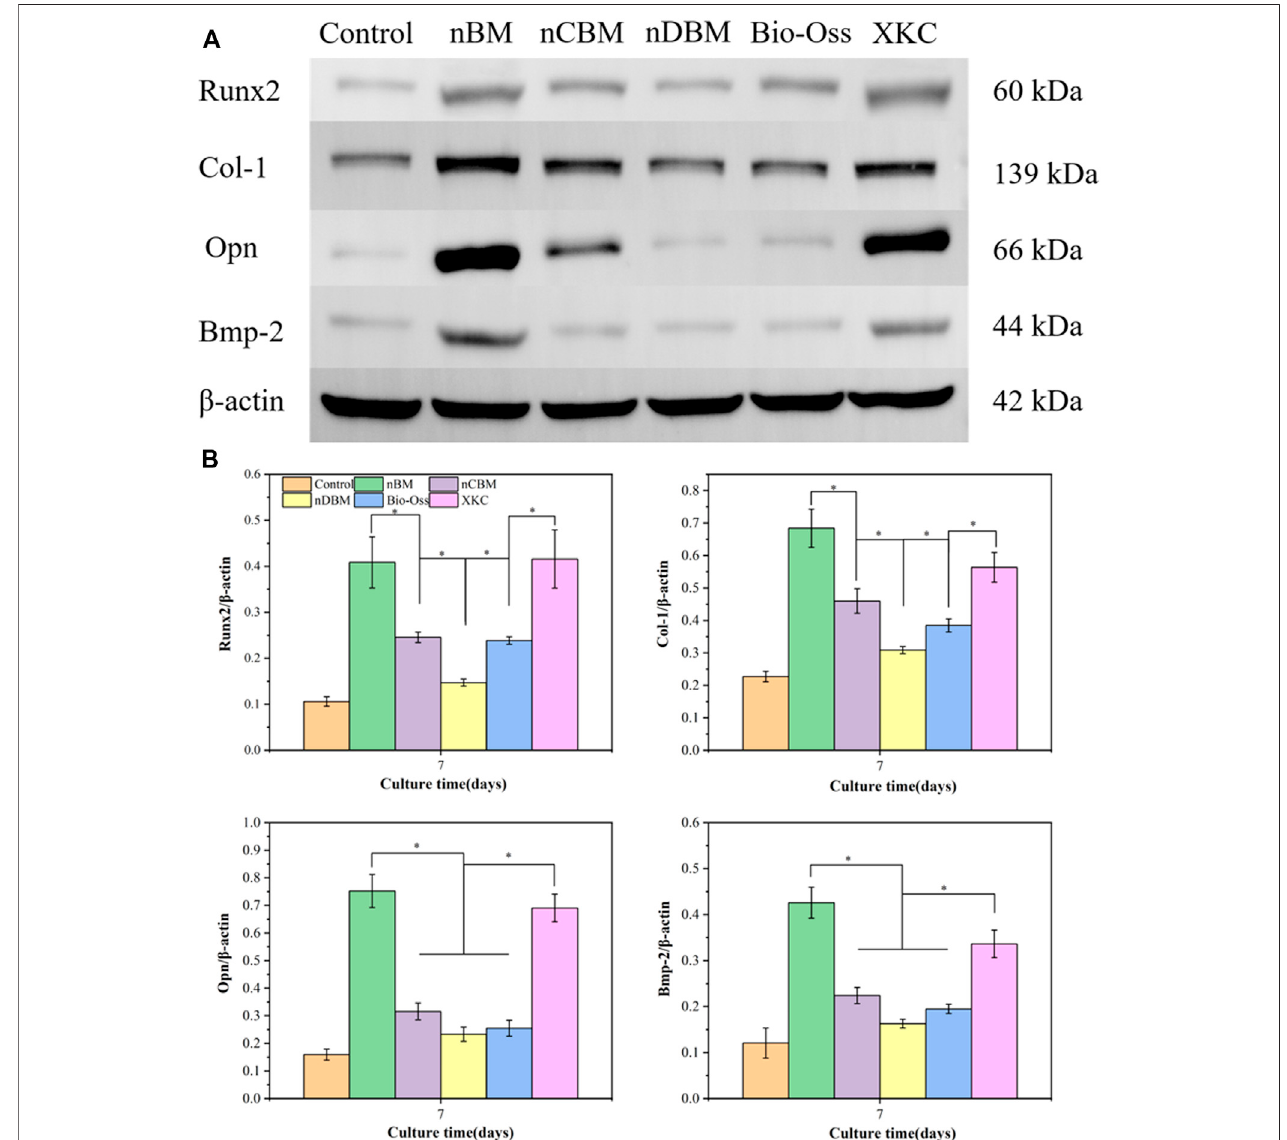
FIGURE13|(A) Westernblottingforprotein-leveldetectionofRunx2,Col-I,Opn,andBmp-2indifferentgroupsofcellsfor7 days. (B) Banddensitometryanalysis of Runx2, Col-I, Opn, and Bmp-2 protein for 7 days. * p < 0.05.